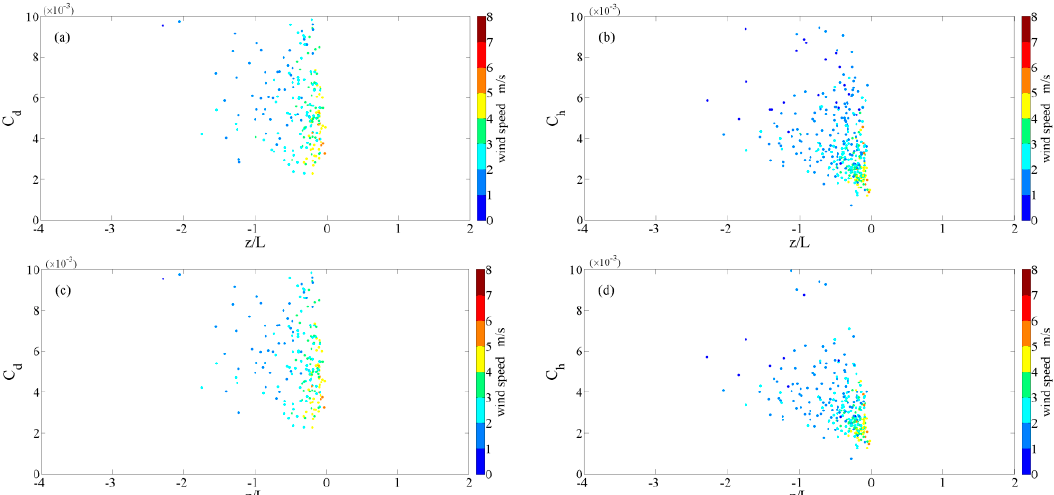
Figure 13. ( a ) Relationship between the bulk transfer coefficients and atmospheric stability with wind directions of NNE–ESE from 5 January to 31 December 2010 according to the Eddy correlation method. ( b ) Same as ( a ) but with wind directions of NNE–ESE. ( c ) Relationship between the bulk transfer coefficients and atmospheric stability with wind directions of NNE–ESE from 5 January to 31 December 2010 according to the unrevised M–O similarity function. ( d ) Same as (c) but revised.